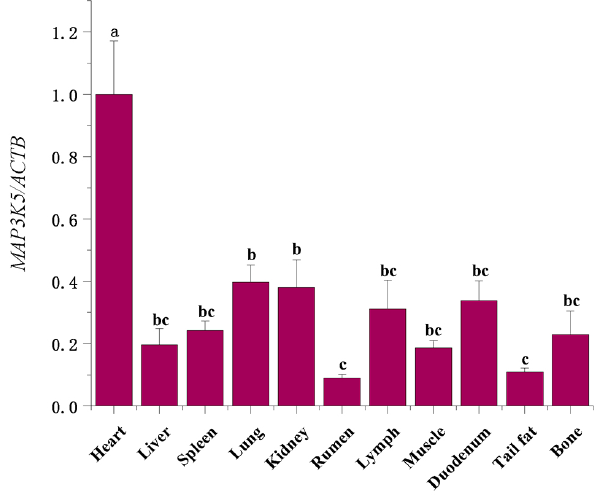
Figure 5. The mRNA expression profiles of the MAP3K5 gene in various tissues of Hu sheep. Different lowercase letters indicate sig- nificant differences ( P < 0 . 05).